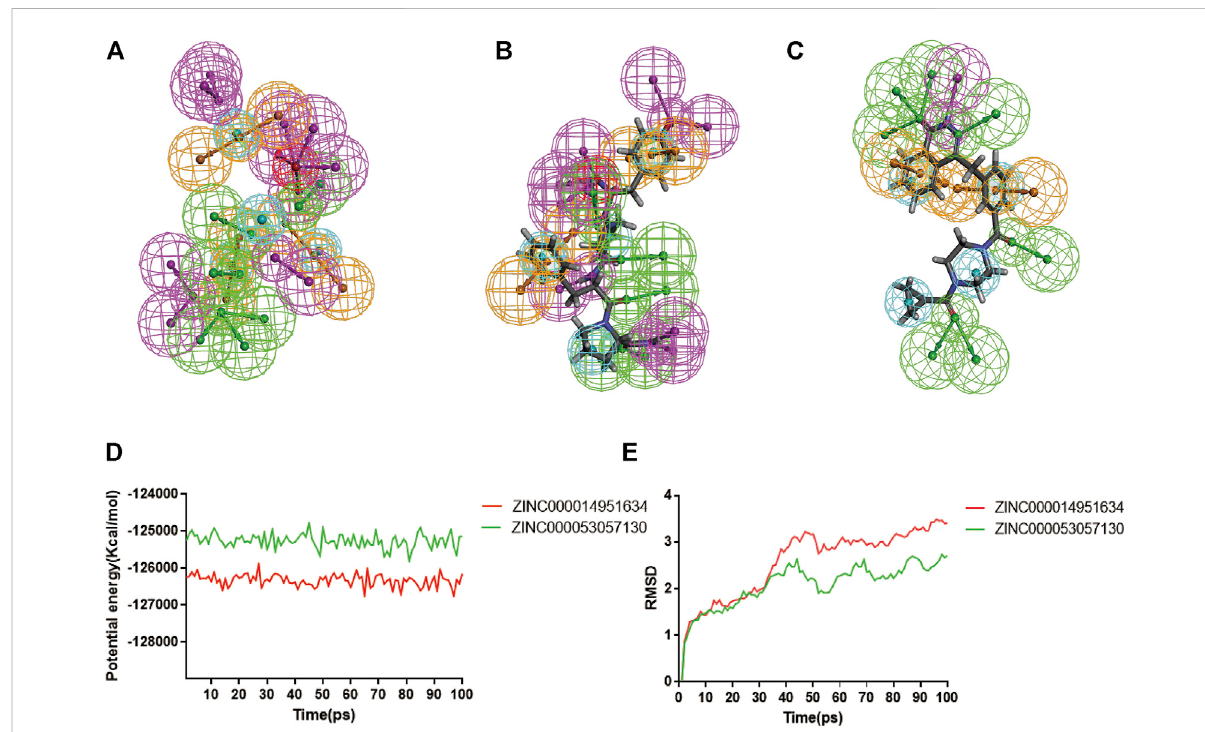
FIGURE 8 Pharmacophore predictions and molecular dynamics simulations of three complexes by DS 4.5. (A) ZINC000014951634: green represents hydrogen acceptor; blue represents the hydrophobic center; purple represents hydrogen donor; yellow represents aromatic ring; red represents inozable positive. (B) ZINC000053057130: green represents hydrogen acceptor; blue represents the hydrophobic center; purple represents hydrogen donor; yellow represents aromatic ring; red represents inozable positive. (C) Lynparza: green represents hydrogen acceptor; blue representsthehydrophobiccenter;purplerepresentshydrogendonor;yellowrepresentsaromaticring. (D) PotentialEnergybymoleculardynamics simulations of ZINC000014951634 and ZINC000053057130; (E) Average backbone RMSD of molecular dynamics simulations to ZINC000014951634 and